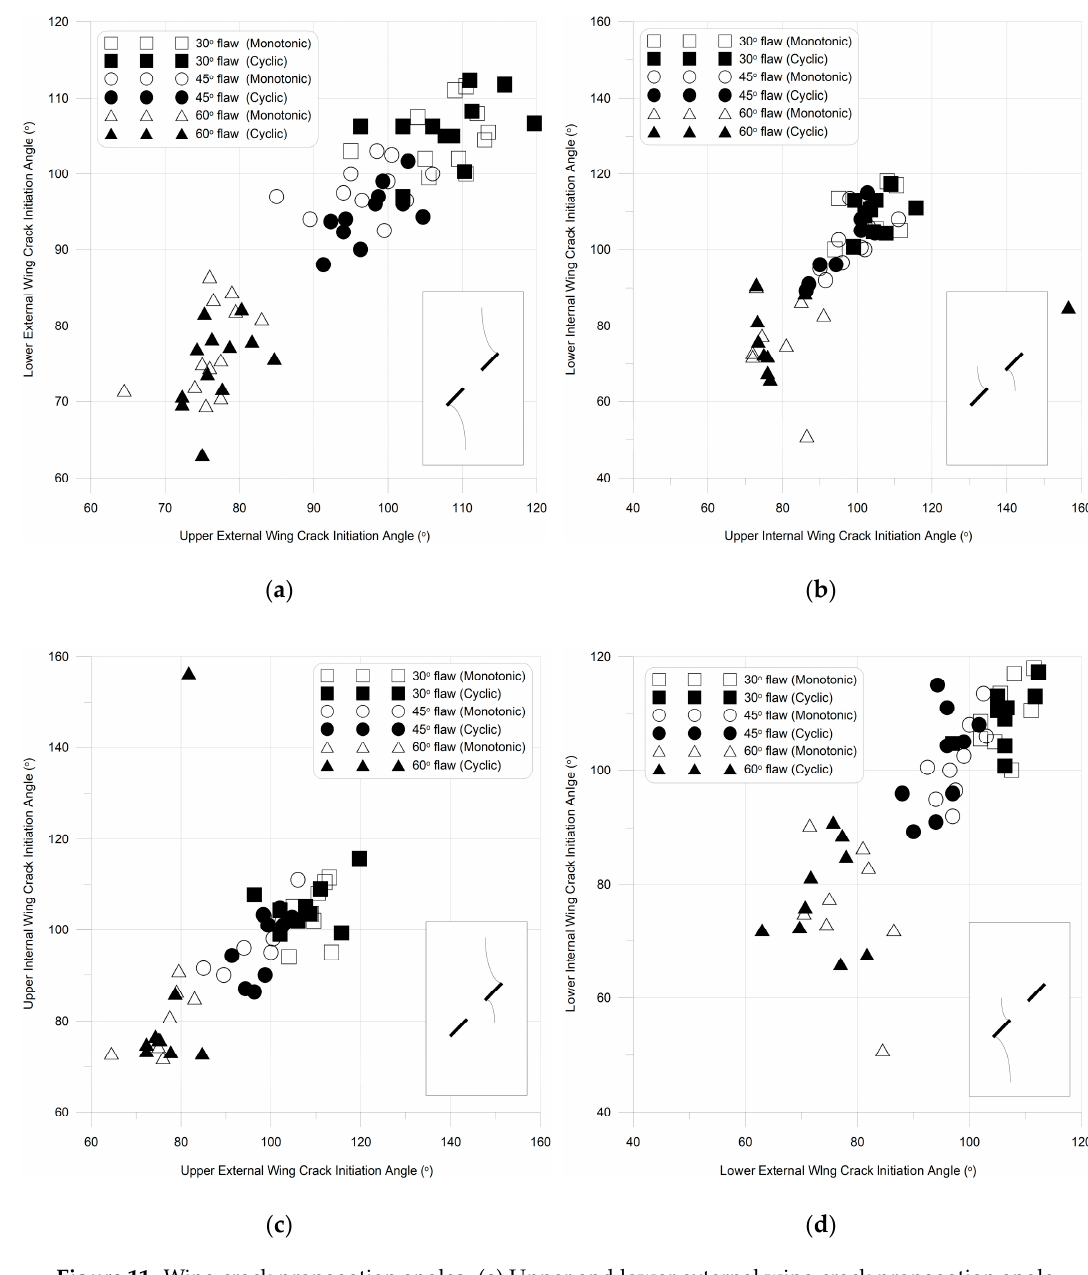
Figure 11. Wing crack propagation angles. ( a ) Upper and lower external wing crack propagation angle. ( b ) Upper and lower internal wing crack propagation angle. ( c ) Upper external and internal wing crack propagation angle. ( d ) Lower external and internal wing crack propagation angle.